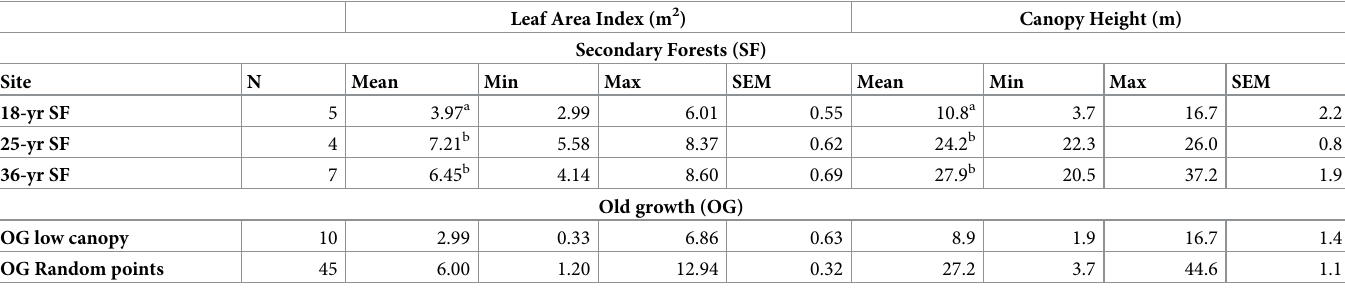
Table 1. Leaf area index and canopy heights based on leaf harvest sampling across a successional gradient at the La Selva Biological Station, Costa Rica. Leaf Area Index (m 2 ) Canopy Height